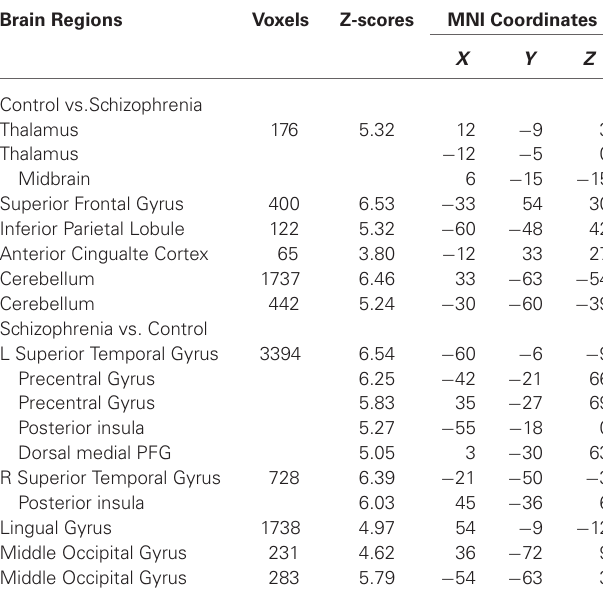
Table 3 | Brain regions showing differences in the thalamus-based functional connectivity between controls and patients with schizohrenia